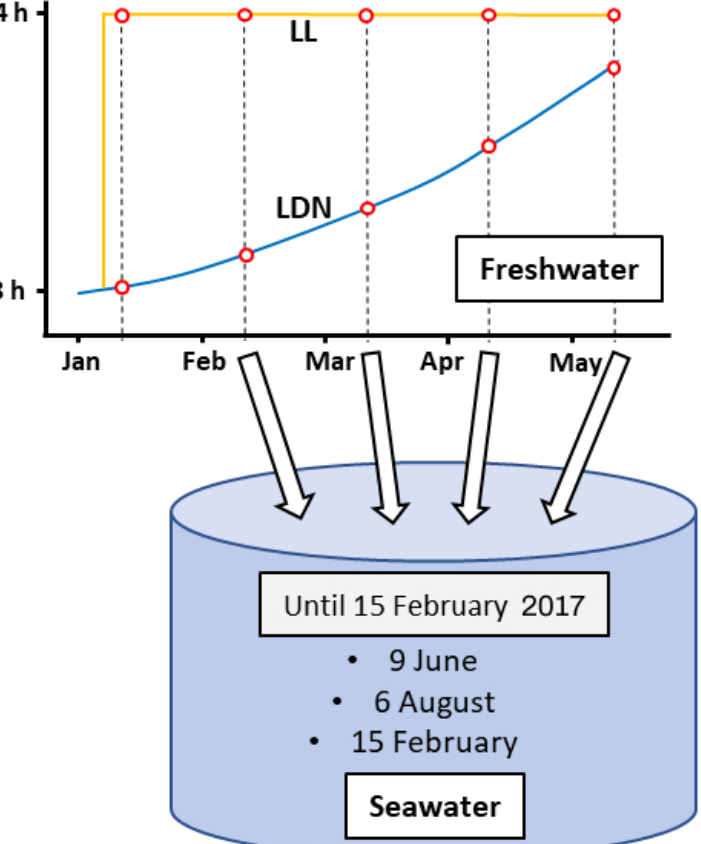
Figure 1. Diagram of the experimental setup. During the period in freshwater, the fish were reared under either continuous light (LL) or natural photoperiod (LDN). Both groups were sampled once a month (represented by red circles) and challenged with a 24-h full seawater challenge test. After this, fish from both photoperiods were transferred to seawater in February, March, April, and May. Samplings in seawater took place on 9 June and 6 August (2016) and 15 February 2017, when the experiment was terminated. (Martinez et al.).